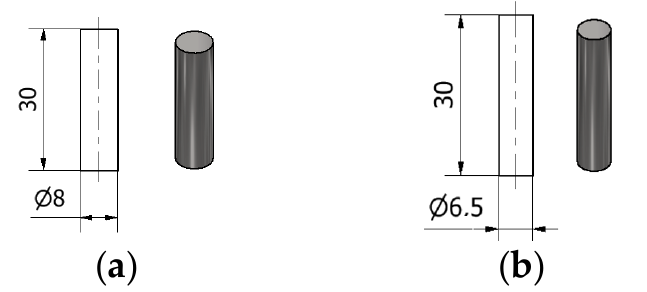
Figure 5. Sample dimensions: ( a ) Co-28Cr-6Mo alloy; ( b ) Co-20Cr-15W-10Ni alloy.